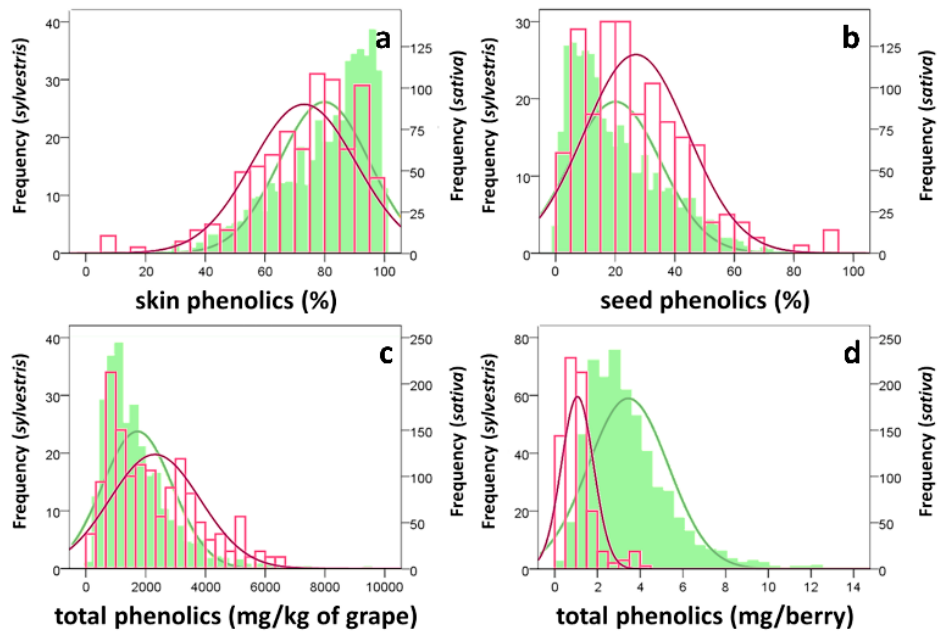
Figure 5. Total phenolics and their origin proportions in Vitis vinifera subsp. sylvestris (in pink) and subsp. sativa (in green). Vitis vinifera subsp. sativa data are already published in Rustioni et al. [26]. ( a ): skin phenolics (%), ( b ): seed phenolics (%), ( c ): total phenolics (mg/kg of grapes), ( d ): total phenolics (mg/berry). Table 1. Sugar concentration, total acidity, and pH for the musts produced with wild grape, Cabernet Sauvignon, and Saperavi grapes. Data is expressed as average ± standard error of the three vintages investigated. Different letters mean significant differences (F-test). #: LS, level of significance: ns,